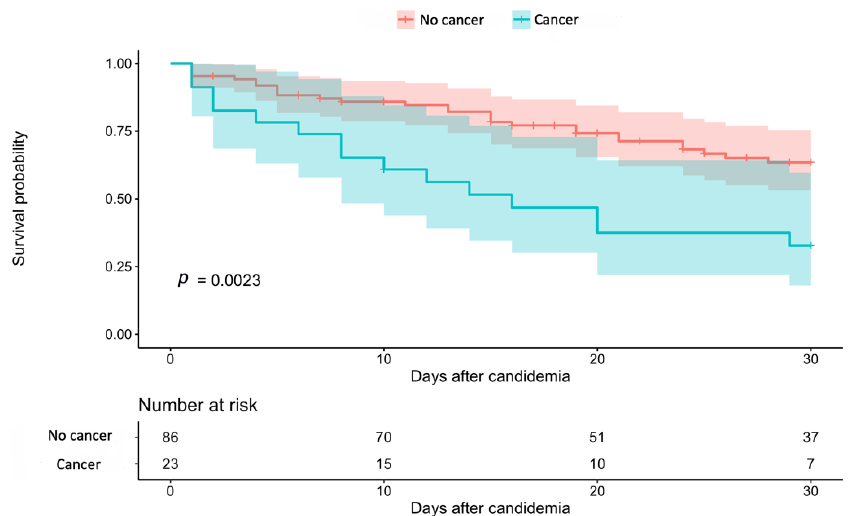
Figure 1. Survival analysis of patients with candidemia according to the time of start of treat- ment.Note: The coloured shadow shows the 95% confidence interval. Time was counted beginning the day the blood sample was taken.